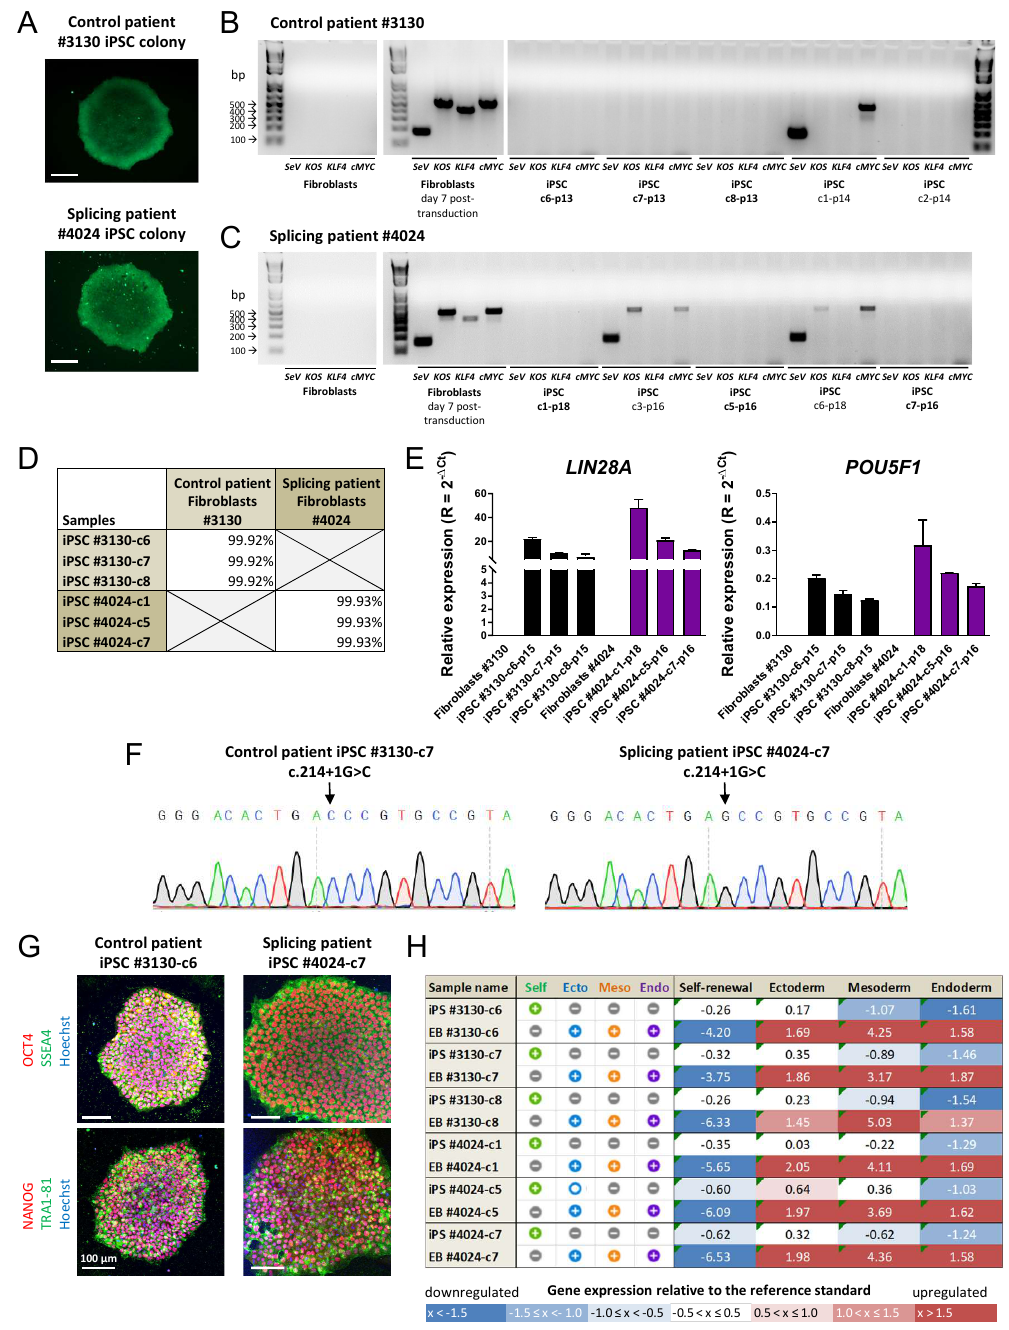
Figure 2. Reprogramming and characterization of patient-derived induced pluripotent stem cells. ( A ) Alkaline phosphatase activity of induced pluripotent stem cell (iPSC) colonies at passage 5. Scale bar: 100 µ m; ( B , C ) RT-PCR analyses of ( B ) #3130 control and ( C ) #4024 splicing patient’s fibroblasts before and 7 days post-transduction and selected iPSC clones after several passages (p13 to p18); ( D ) percentage of single nucleotide polymorphism (SNP) concordance between each iPSC clone and corresponding fibroblasts; ( E ) quantitative PCR analysis of specific stem cell markers LIN28A and POU5F1 . Error bars represent technical replicates of samples from a single passage; ( F ) Sanger sequencing confirming the presence of the risk allele in the splicing patient iPSCs; ( G ) immunocytochemical analysis of iPSCs for pluripotent nuclear proteins OCT4 and NANOG, and surface markers SSEA4 and TRA1-81. Scale bar: 100 µ m; ( H ) Scorecard analysis with values comparing the expression profile of self-renewal, ectoderm, mesoderm and endoderm genes in iPSCs and in vitro-formed embryoid bodies relative to a reference iPSC standard